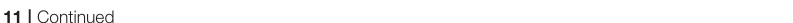
FIGURE 11 | Continued peak light intensity of over 2,000 µ mol m − 2 s − 1 . (B) Growth status of the wild-type and ygl18 plants under above three light conditions. Eight-day-old seedlings were planted in the fields and encountered one cloudy day and subsequent 18 sunny days (condition 1, 2, and 3). Plants were observed after 0, 9, and 18 days in sunlight (DIS). The black arrows indicate the withered leaves. (C) Chlorophyll contents of the wild-type and ygl18 plant leaves at 9 DIS. Data represent the mean ± SD of three biological replicates (one-way ANOVA analysis); FW, fresh weight. (D) Plant height of the wild-type and ygl18 plants at 0, 9, and 18 DIS under above three conditions. Data represent the mean ± SD of over eight independent plants (Student’s t -test: *** P < 0.0005). ND, not detected for dead plants. Different letters indicate values are statistically different based on a one-way ANOVA